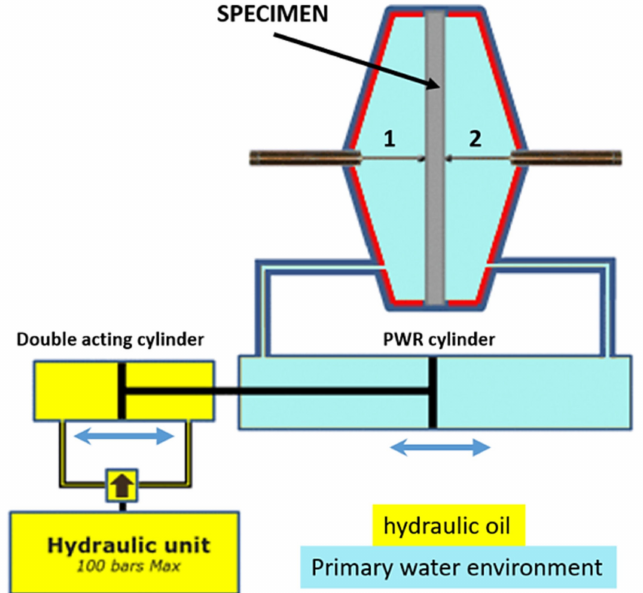
Figure 4. Double cylinder system for the separation of the PWR and hydraulic